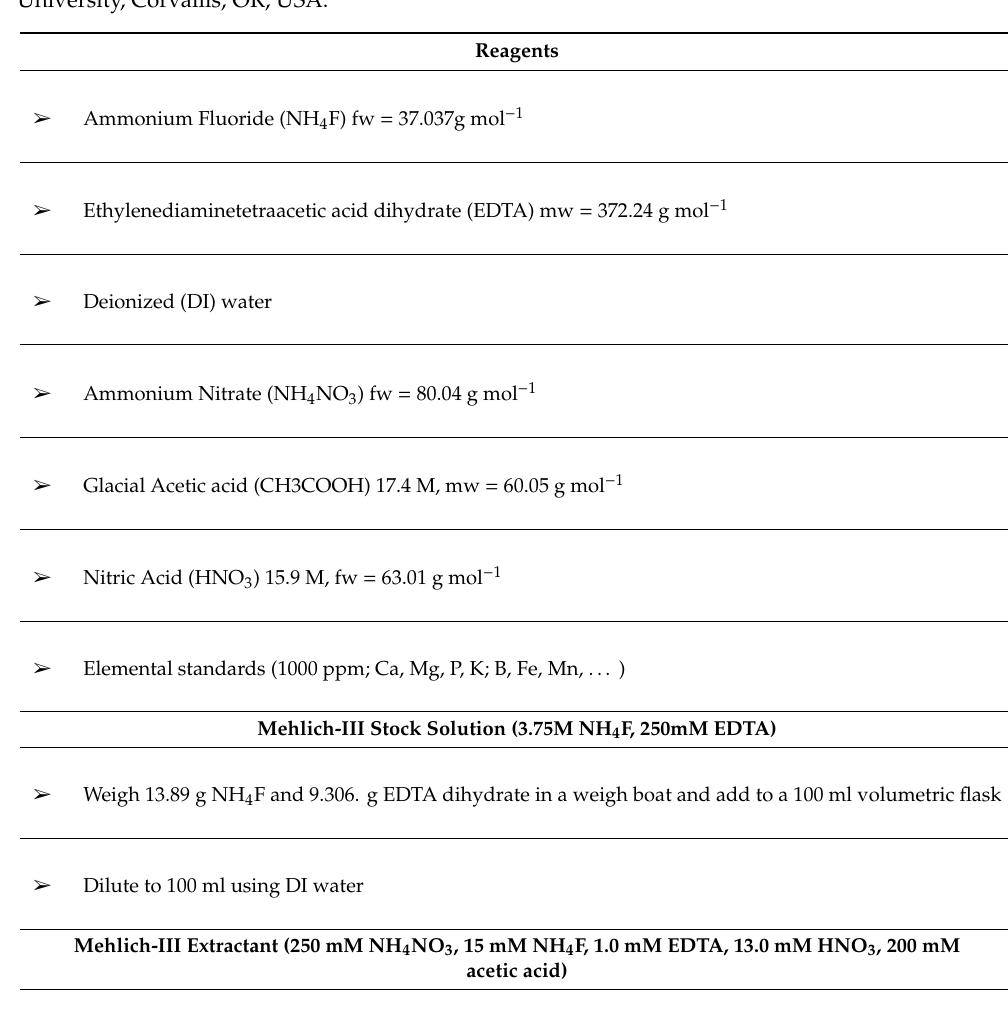
Table A1. Mehlich-III soil extraction protocols for Central Analytical Laboratory, Oregon State University, Corvallis, OR,